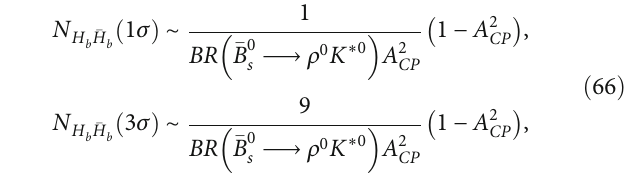
(cid:1) ⟶ ρ 0 ð ω Þ K ∗ 0 , B 0 s